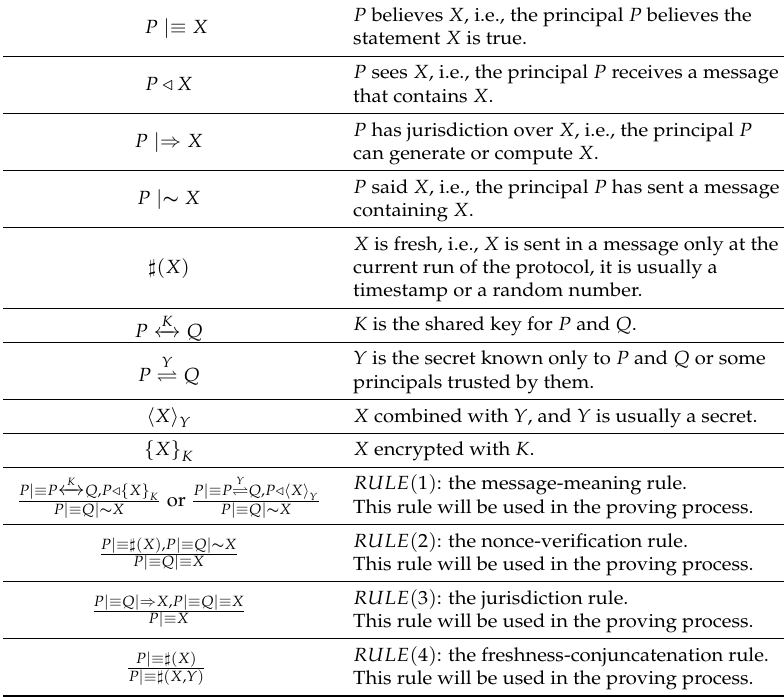
Table 2. Notations in BAN